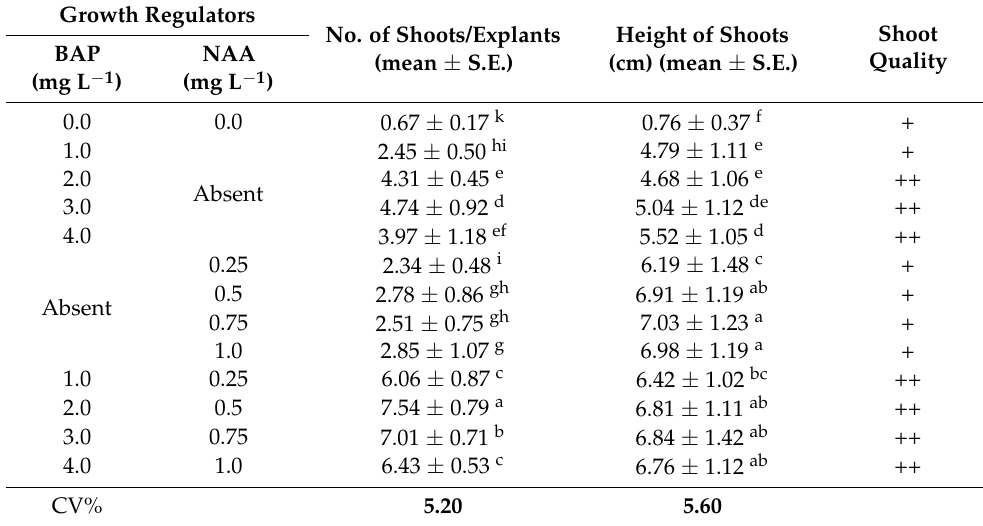
Table 2. BAP and NAA’s impact on shoot multiplication (after 8 weeks of culture). Growth Regulators